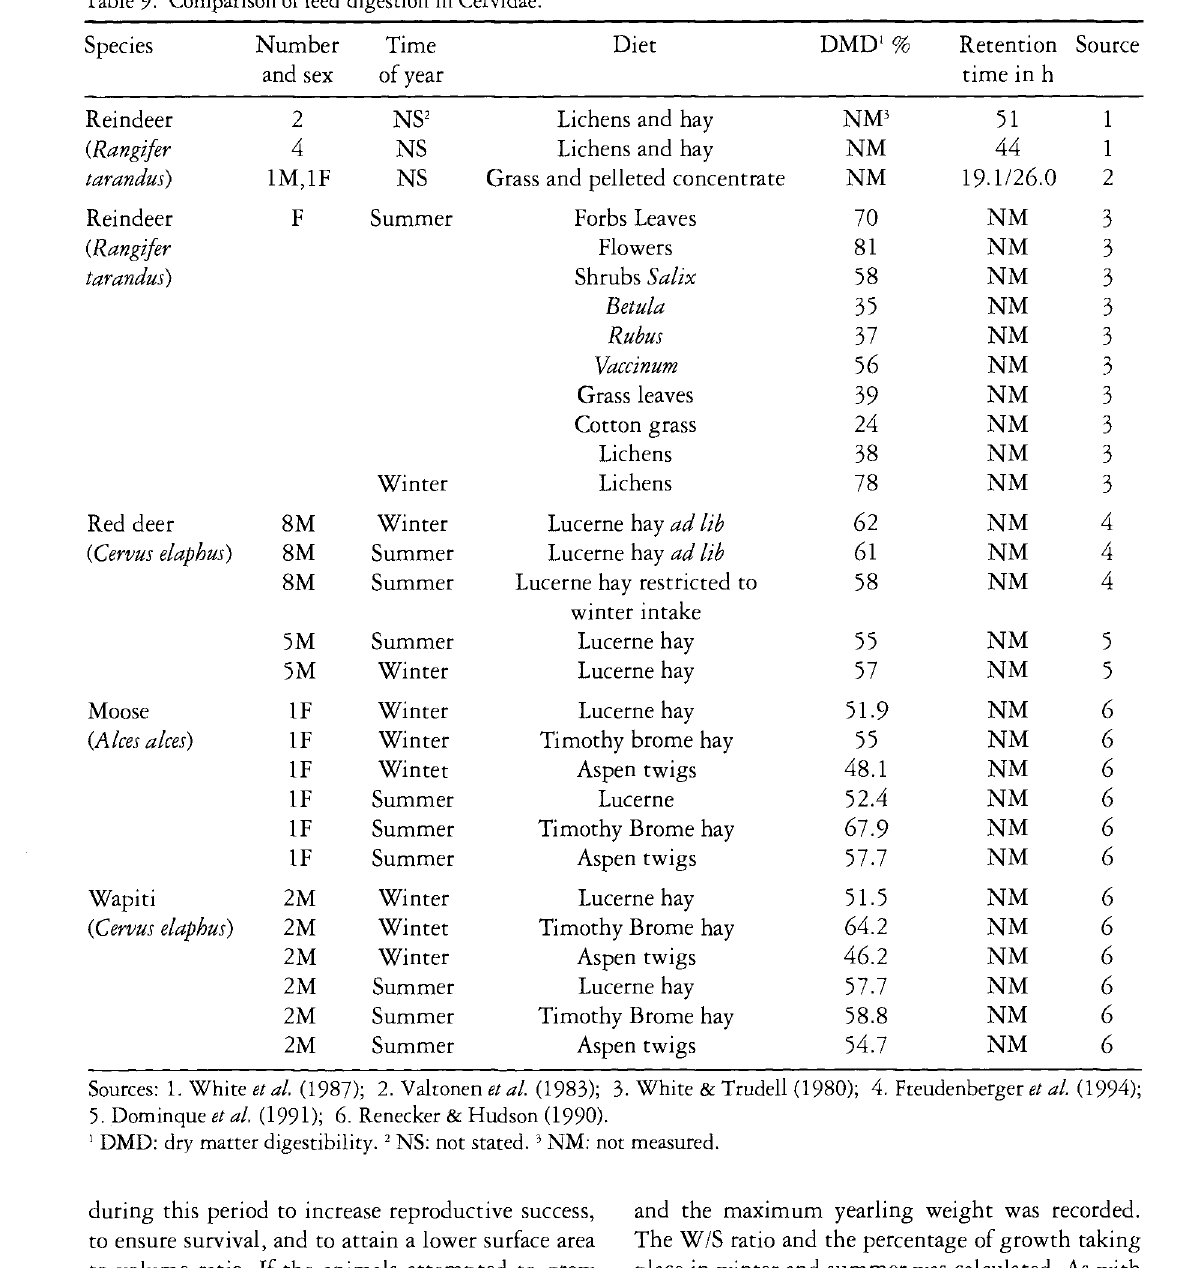
Fig. 5 is a representative set of data.